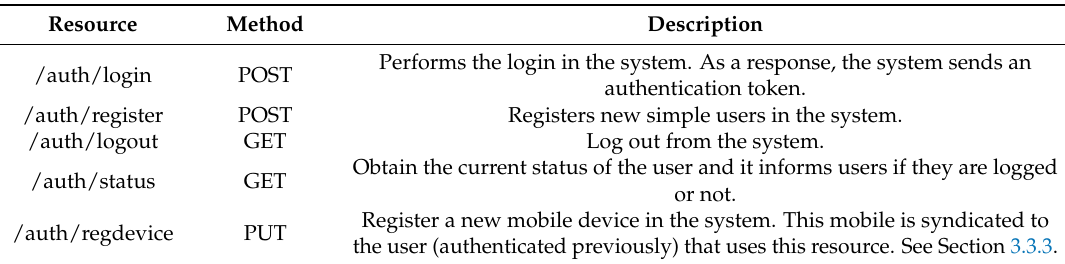
Table 1. Resources provided by the Identity Manager